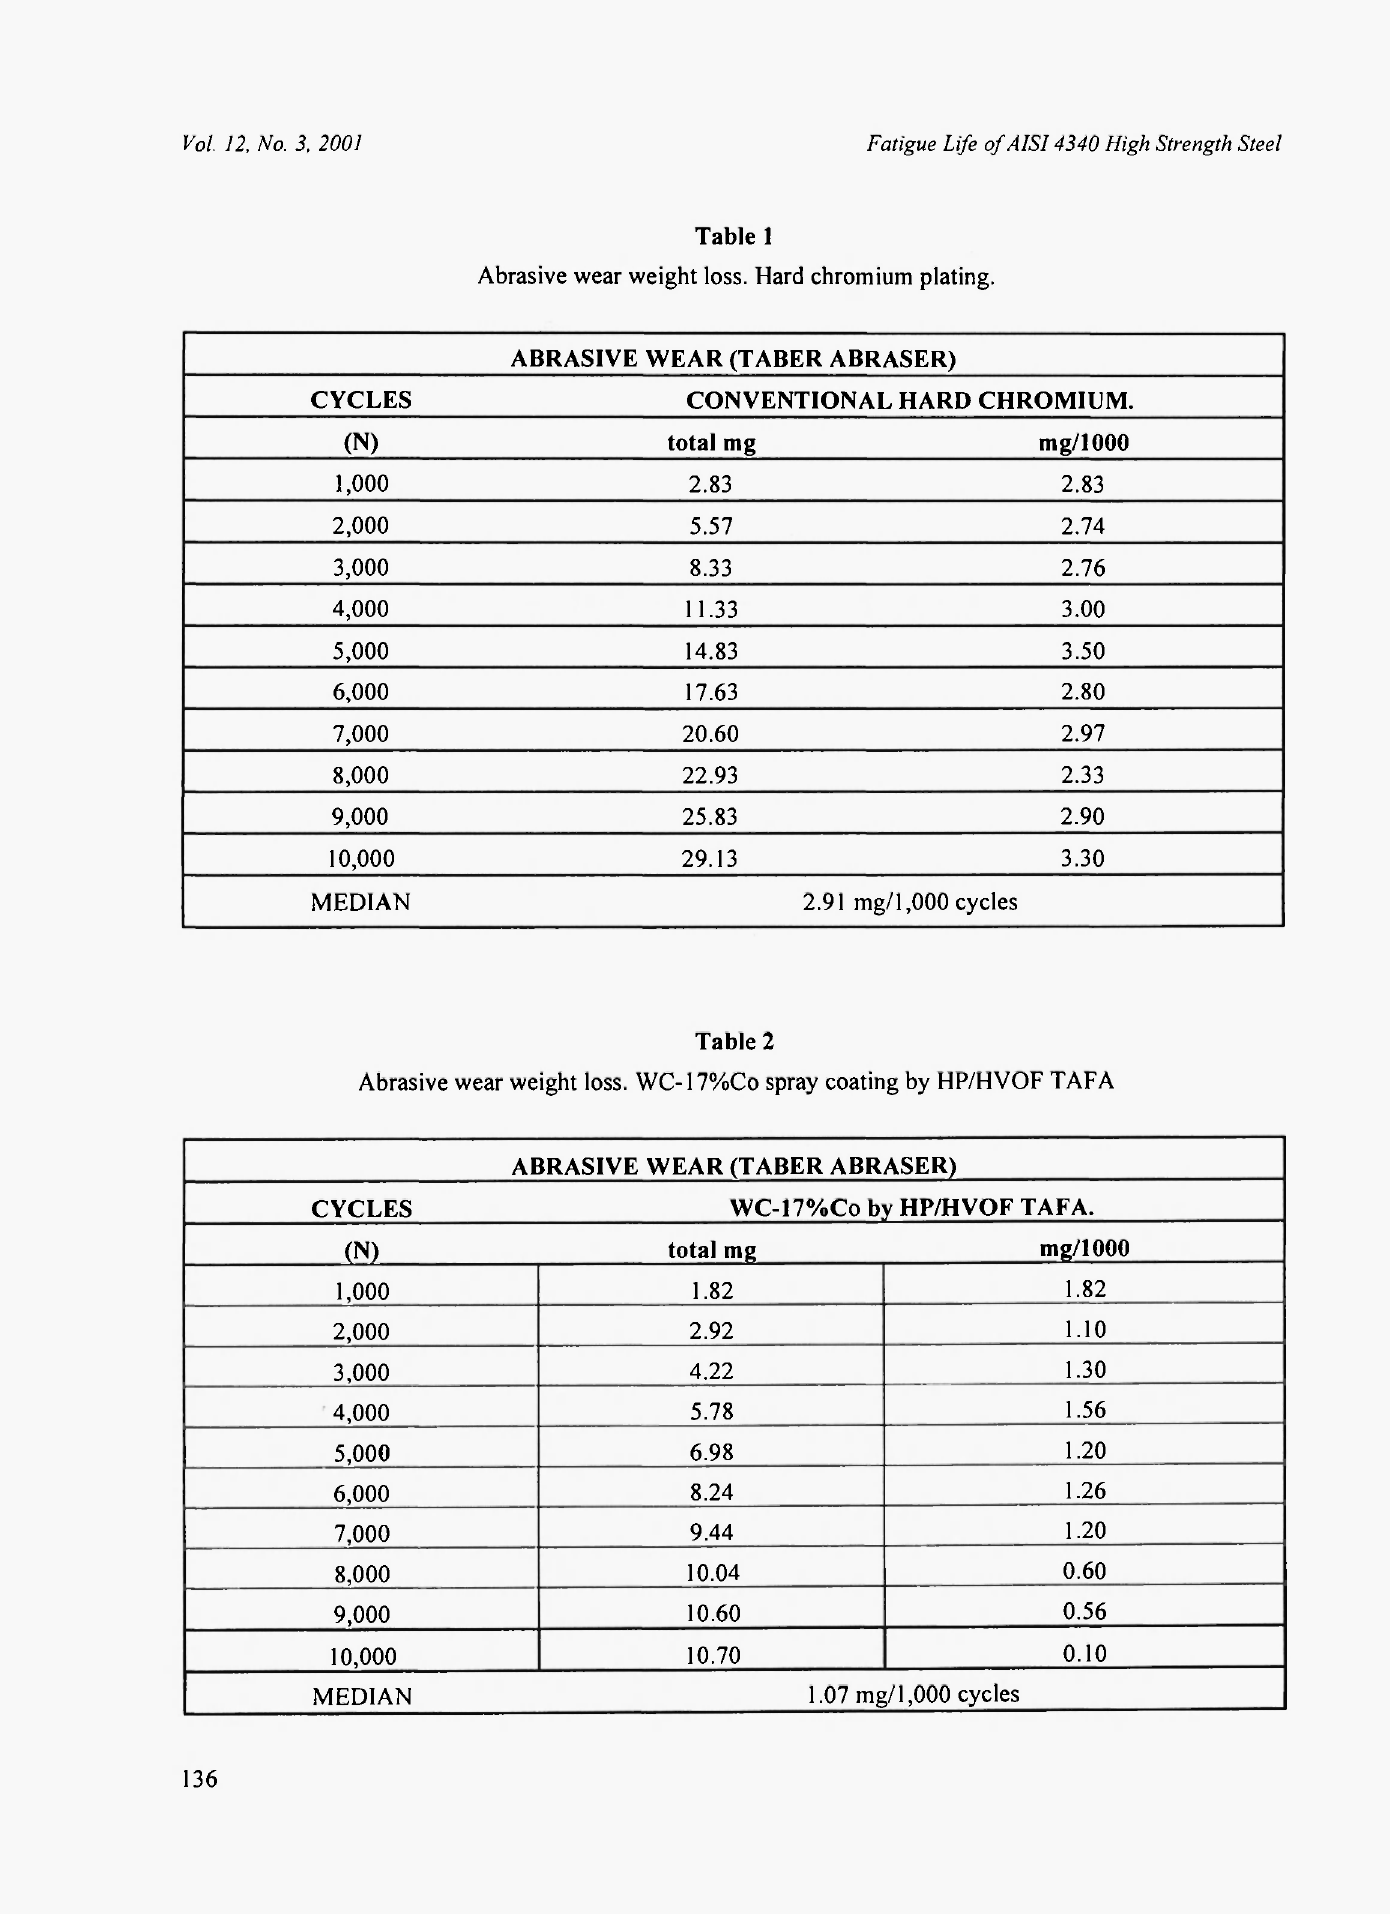
Abrasive wear weight loss. Hard chromium plating.